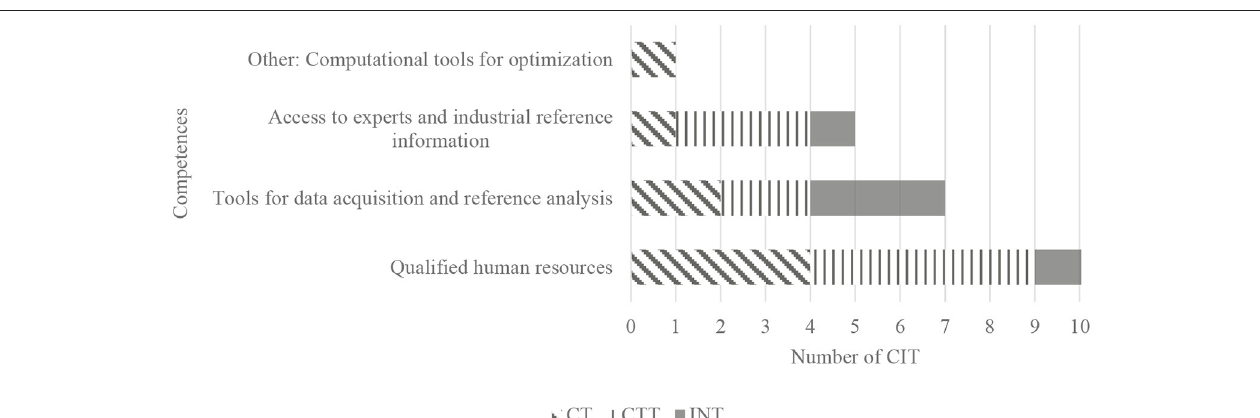
FIGURE 6 | Competences to perform diagnoses and propose circularity strategies.